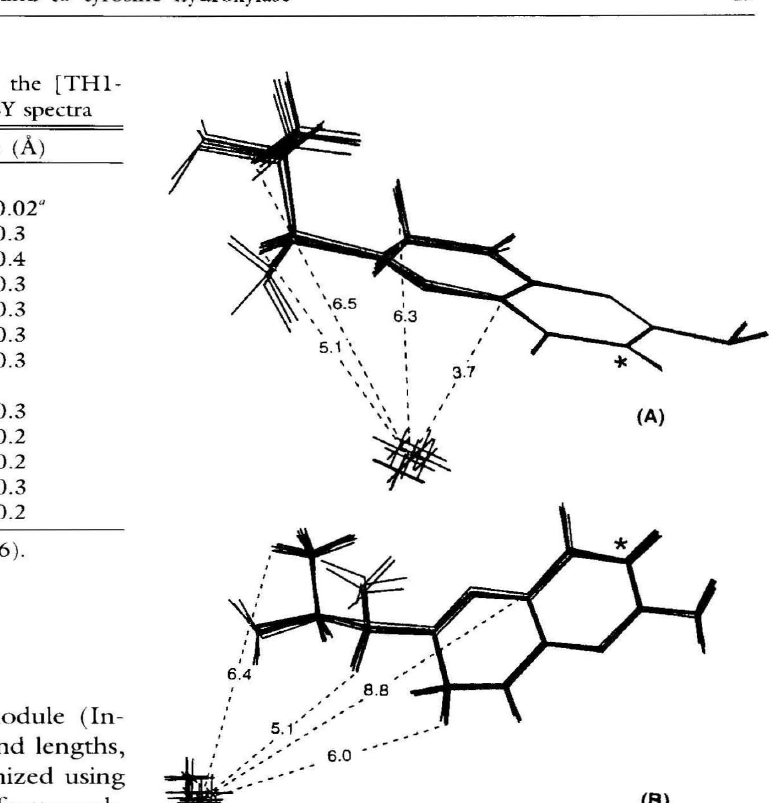
Table 2. Calculated interproton distances in the [THI